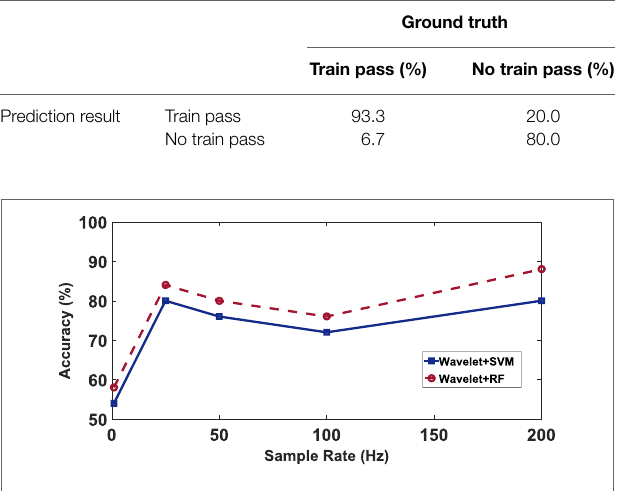
FIGURE 9 | Accuracy under different sample rates based on (1) red line: wavelet coefficients as features and Support Vector Machine as classification model; (2) blue line: wavelet coefficients as features and Random Forest as classification model